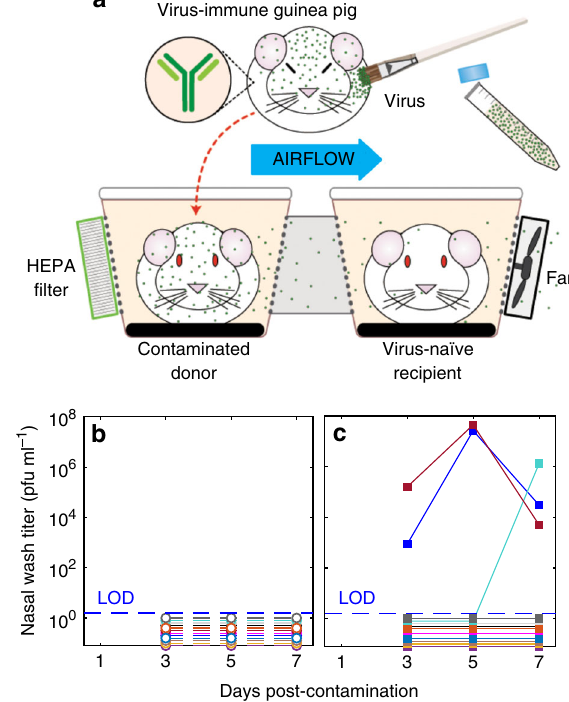
Fig. 3 In fl uenza virus-naive guinea pigs are infected by aerosolized fomites. a Transmission experiment schematic, showing a virus-naive recipient guinea pig placed downwind of, but physically separated from, a virus-immune, virus-contaminated donor guinea pig. b Nasal wash virus titers, in plaque-forming units (pfu) ml − 1 , from 12 immune, contaminated donor guinea pigs, each represented by a different color. c Nasal wash virus titers from 12 recipient guinea pigs. Each color represents an individual recipient. Dotted line indictes the limit of detection (LOD). Source data are provided as a Source Data fi